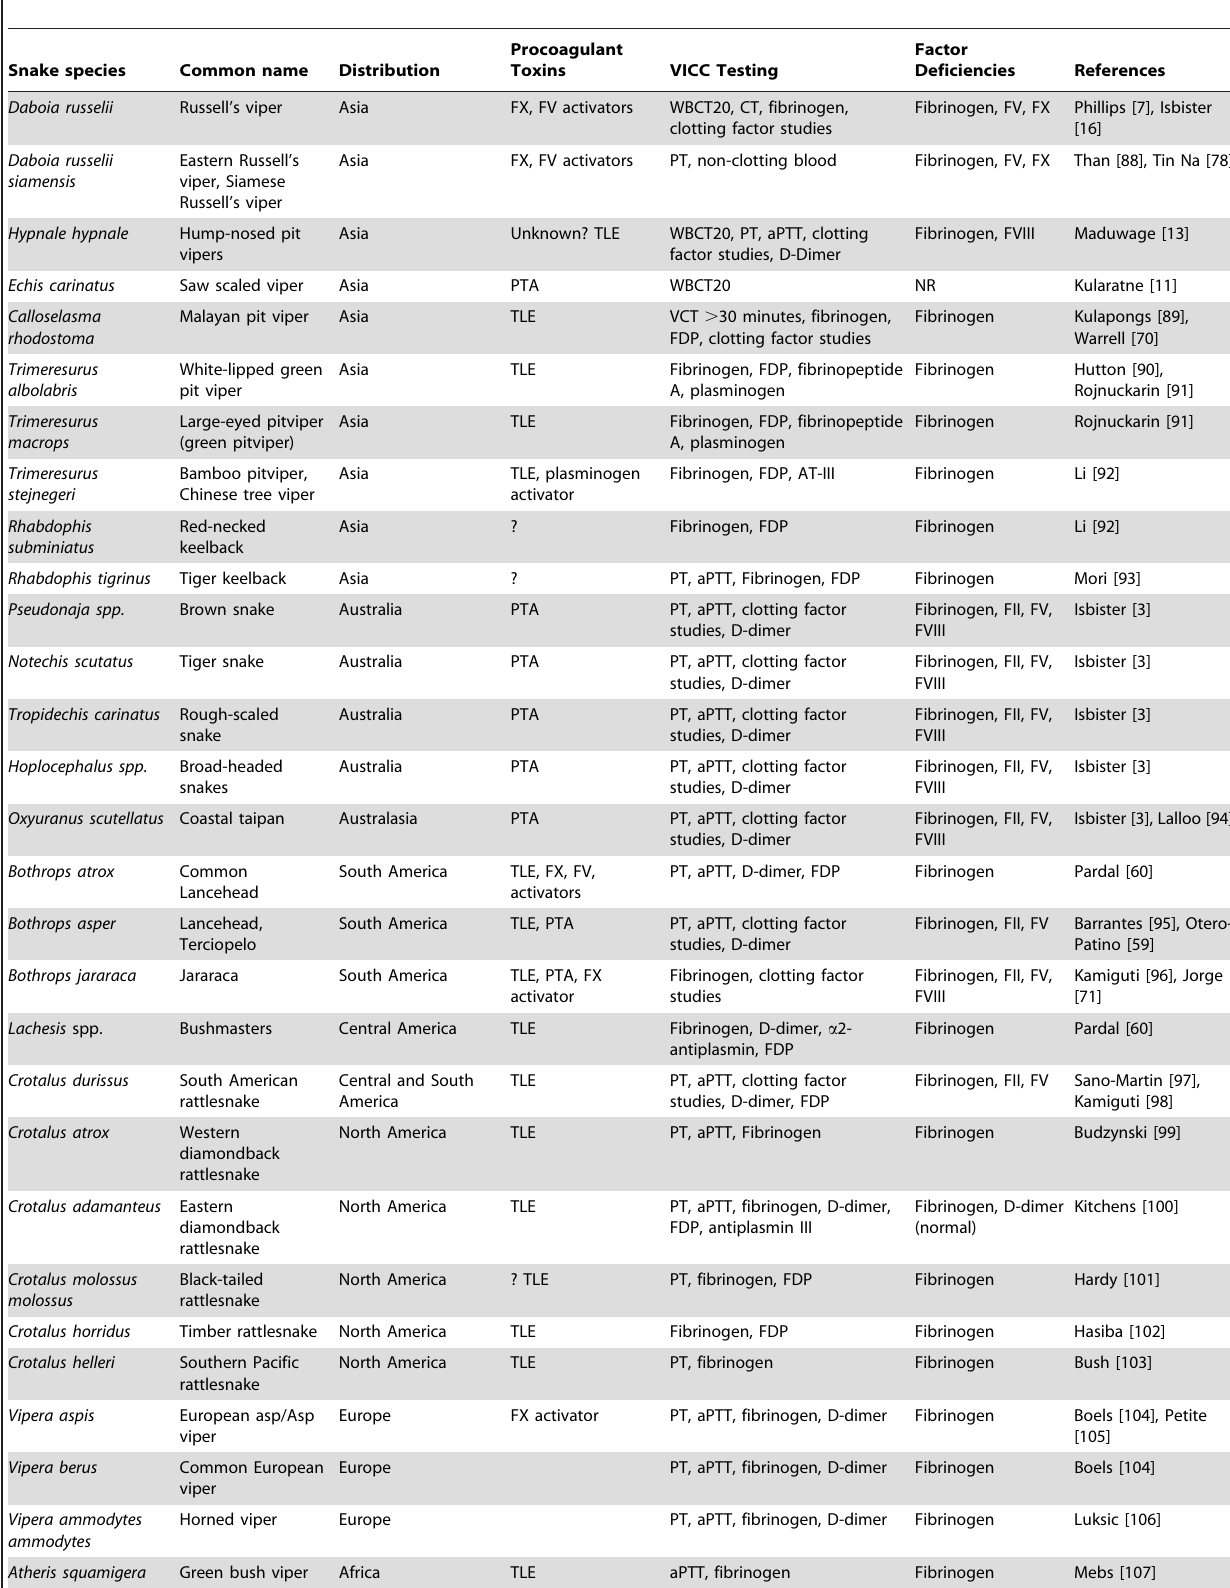
Table 1. Summary of snakes known to cause venom-induced consumption coagulopathy, the procoagulant toxin, and the factor deficiencies that have been reported (with permission from